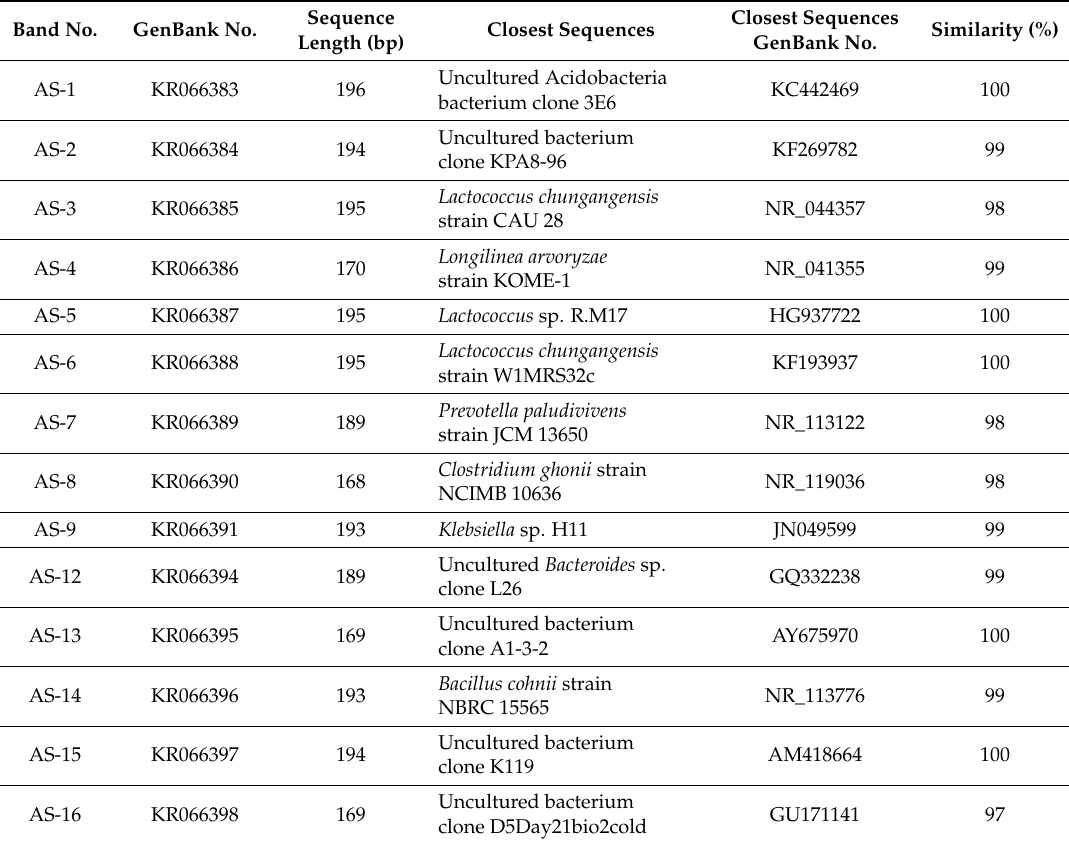
Table 3. 16S rDNA sequence analysis and species identification of selected dominant DGGE bands for the anaerobic